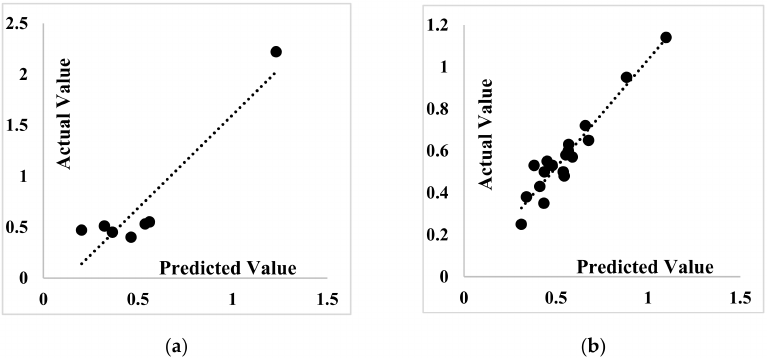
Figure 13. Scatter plot of the SP demand prediction for ANFIS-ACO: ( a ) Testing phase, ( b ) training phase.